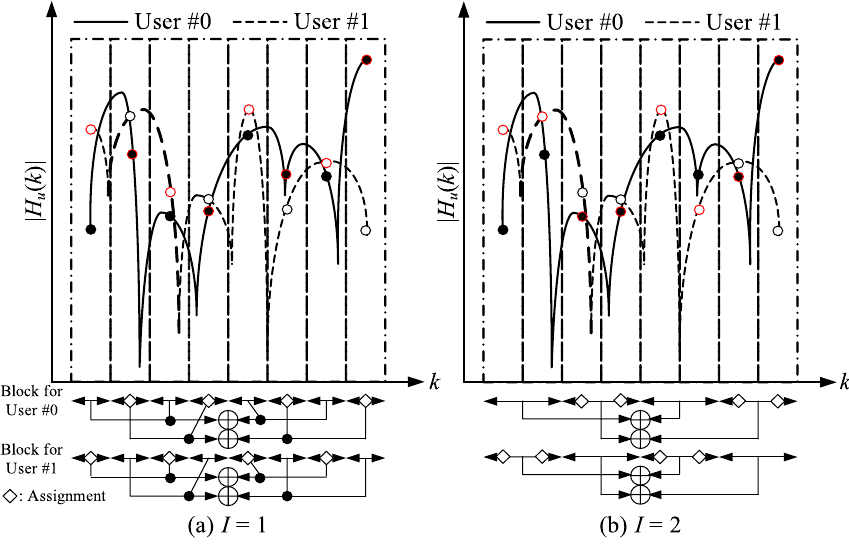
Fig. 4 Example of the proposed interleaved block subcarrier allocation for N c = 8 , N u = 2 , and I = 1 and